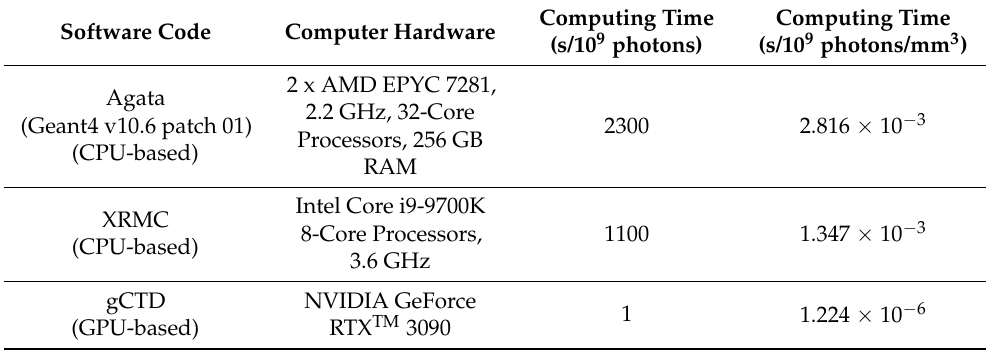
Table 1. Summary of the used software and hardware and computation times that are estimated for the case studies in sect. 3.3. The phantom volume was 8.16 × 10 5 mm 3 . Software Code Computer Hardware